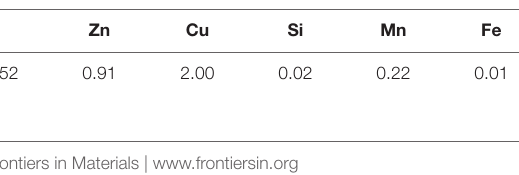
TABLE 1 | Chemical composition of the AZ31 alloy (wt. %).